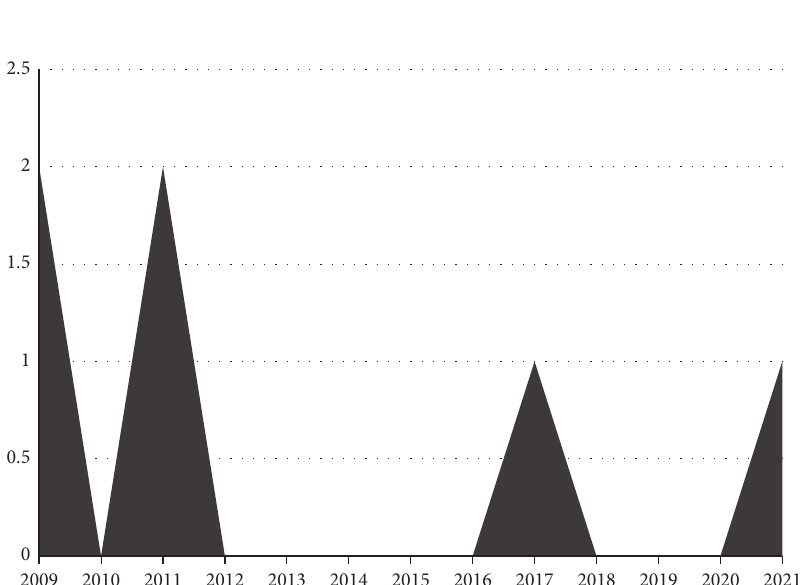
Figure 6: Number of VE articles related to technology development by